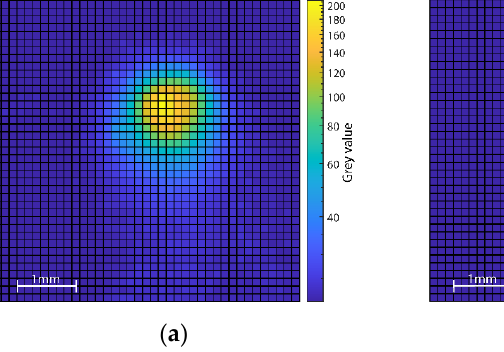
Table 1. Laser energy outputs and travel speeds.